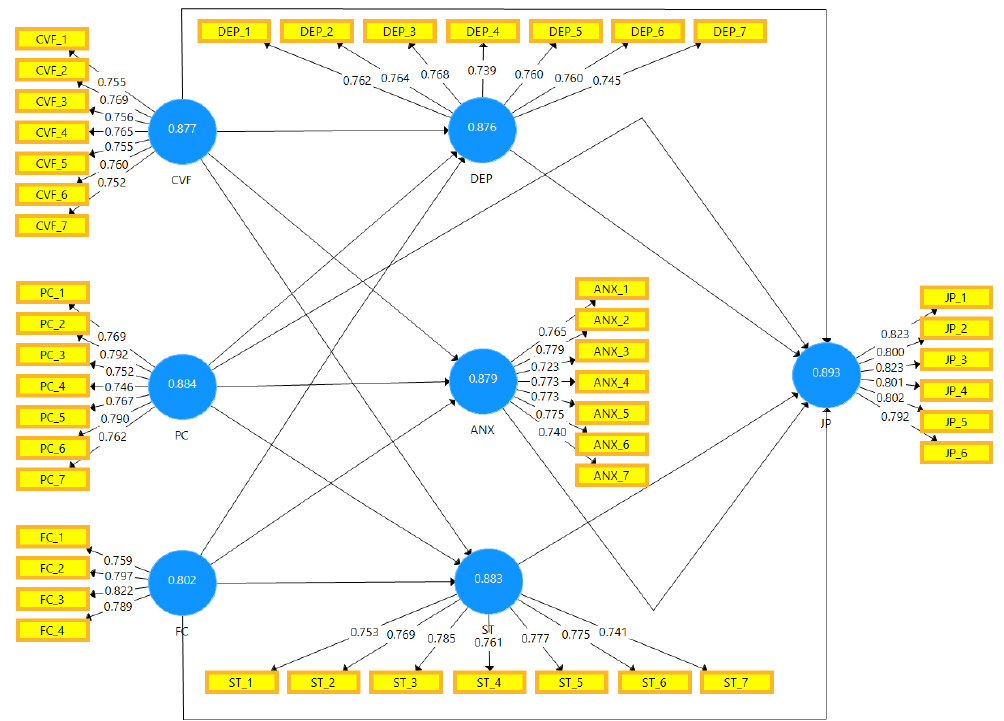
Figure 2. Graphical Representation of Assessment of Measurement Model.